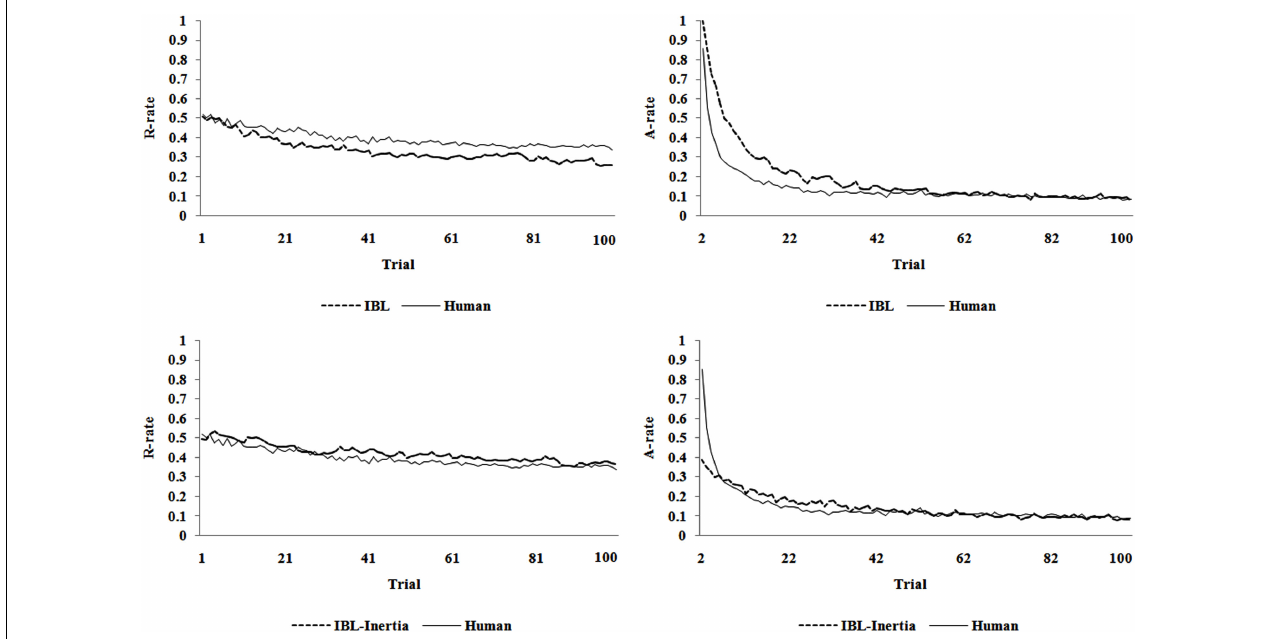
FIGURE 2 |The R-rate andA-rate across trials predicted by the IBL and IBL-Inertia models and that observed in human data in theTPT’s estimation set.